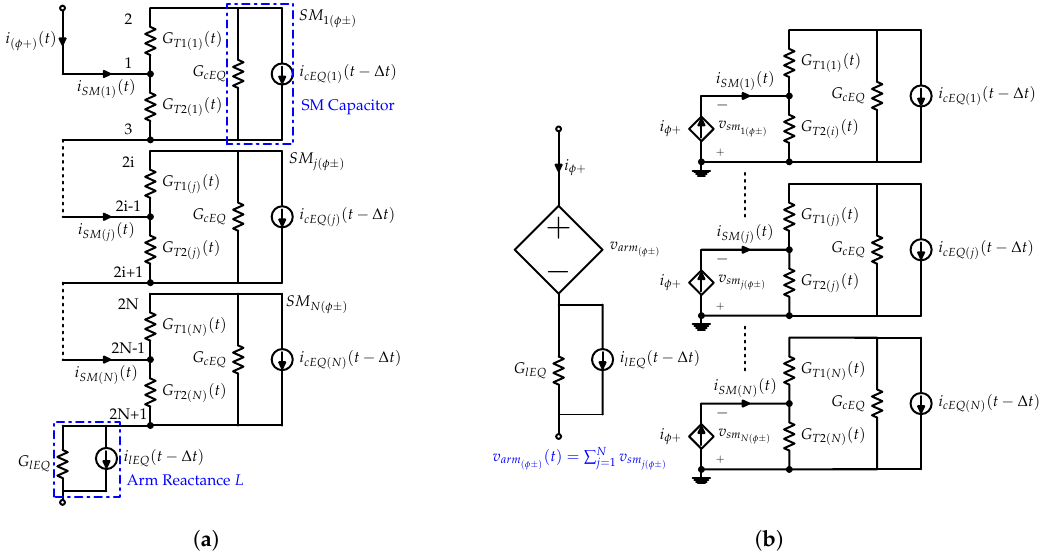
Figure 4. Equivalent representation for an arm. ( a ) EMT equivalent model; ( b ) isolated submodule model (ISM)-equivalent representation for an